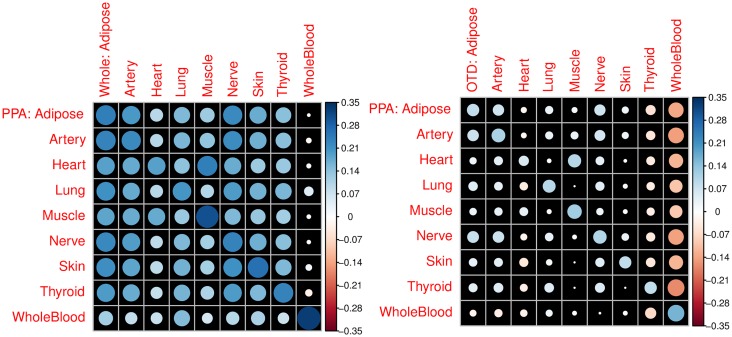
Comparison of heritability of whole tissue or tissue-specific components vs. PPA.Panel (A) of this figure shows the Pearson correlation (R) between the BSLMM PVE of the original (we are calling whole here) tissue expression levels vs. the probability of the tissue being actively regulated in a given tissue (PPA). Matching tissues show, in general, the largest correlation values but most of the off diagonal correlations are also relatively high consistent with the shared regulation across tissues. Panel (B) shows the Pearson correlation between the PVE of the tissue-specific component of expression via orthogonal tissue decomposition (OTD) vs. PPA. Correlations are in general lower but matching tissues show the largest correlation. Off diagonal correlations are reduced substantially consistent with properties that are specific to each tissue. Area of each circle is proportional to the absolute value of R.